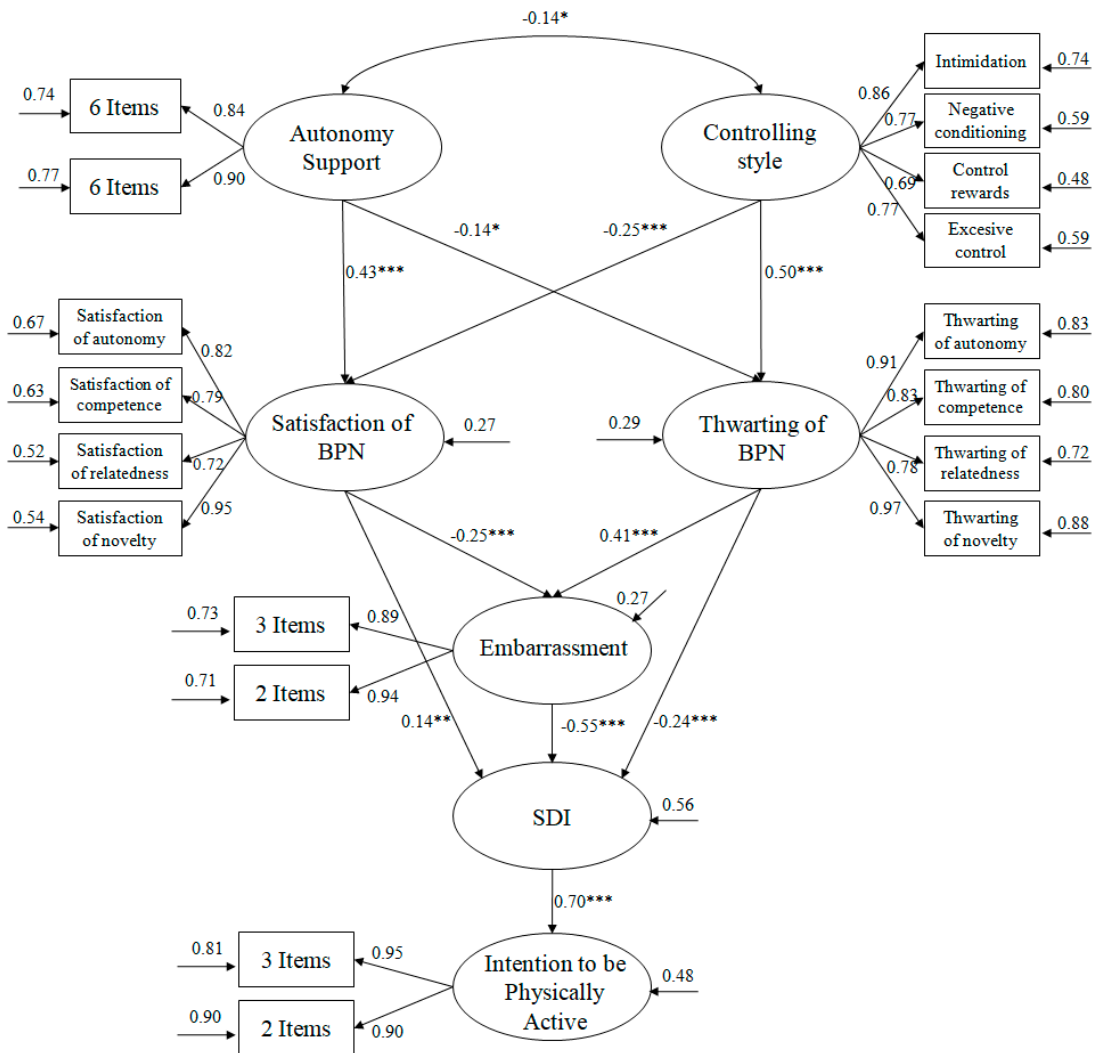
Figure 1. Of structural equations showing the relationships between the different variables. All parameters are standardized and statistically significant. The variances explained are shown above the small arrows. Note: *** p < 0.001;** p < 0.01; * p < 0.05.